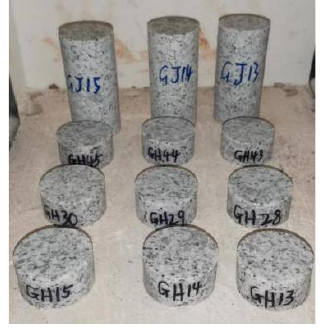
Figure 1. Granite